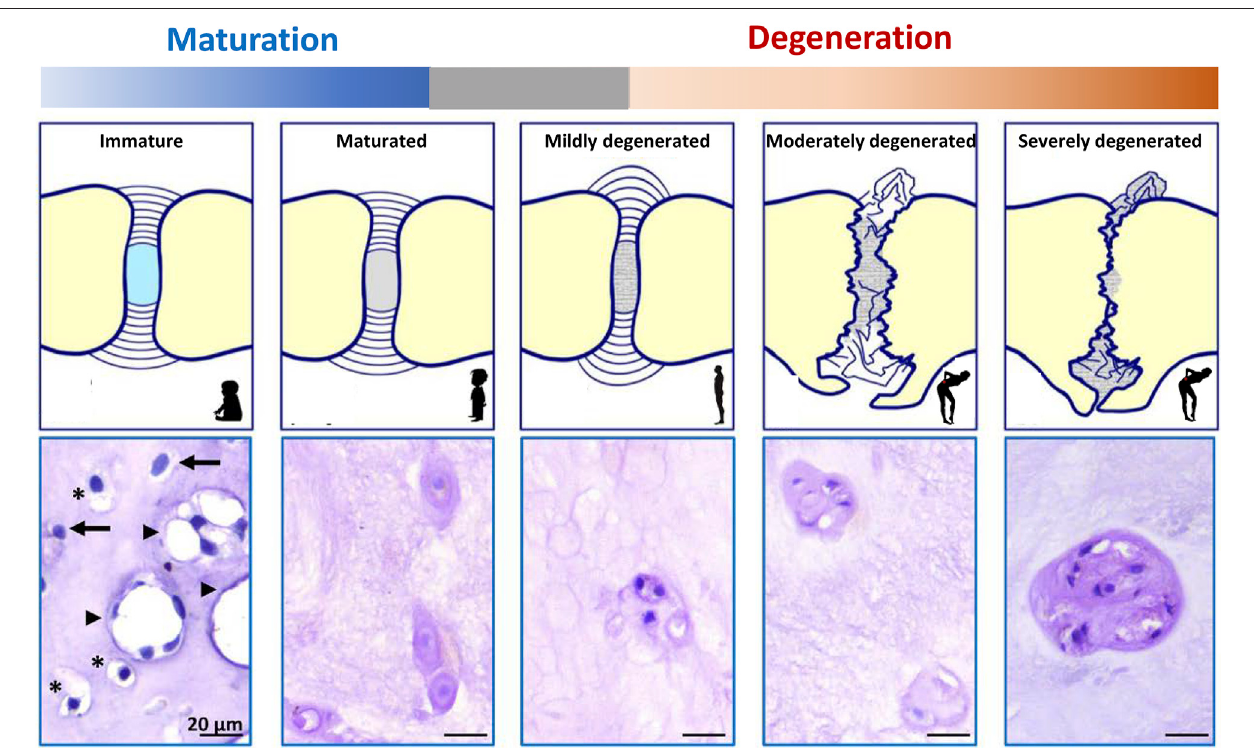
FIGURE 2 | Schematic representation of intervertebral disc (IVD) maturation and degeneration during human life. During IVD maturation, a transition in nucleus pulposus (NP) cell phenotype occurs from large, vacuolated notochordal cells (NCs) to smaller, non-vacuolated nucleus pulposus cells (NPCs). Humans have lost (almost) all their NCs before adulthood. In immature human NPs ( e.g,. fetuses and babies), vacuolated NCs (arrowhead), transitional cells with some small vacuoles remaining (*), and non-vacuolated NPCs (arrow) or only NPCs are present (dependent on the fetal stage/age of the donor). In maturated human IVDs ( e.g., individuals > 10 years), only NPCs are present. Degenerated IVDs contain single NPCs, or small or large clusters of NPCs (as a reactive reparative response during moderate/severe degeneration).